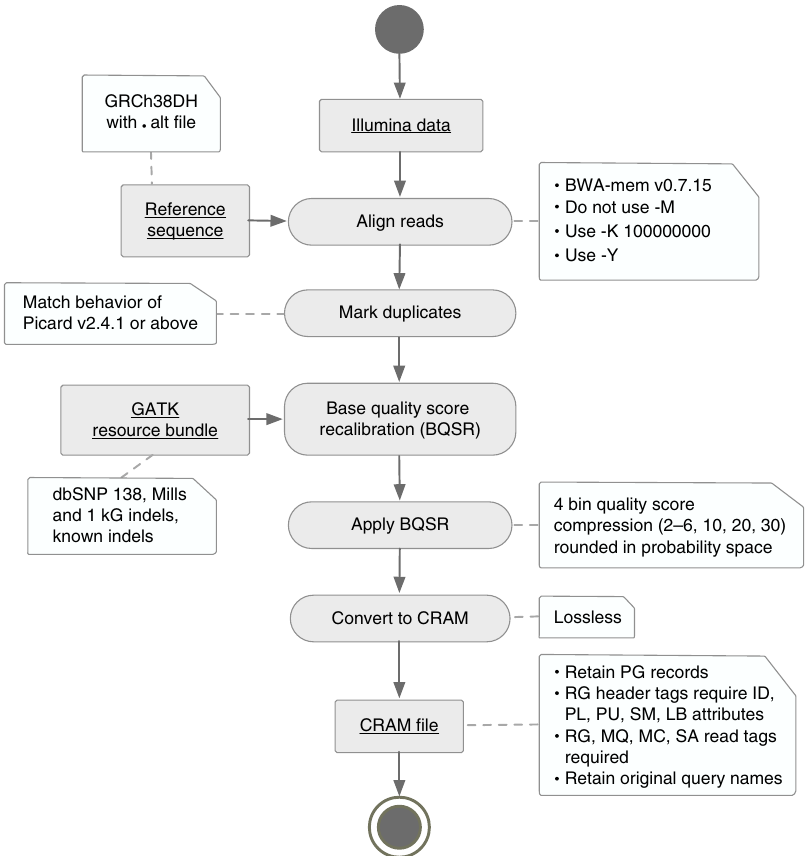
Fig. 1 Highlights of functional equivalence standard. We de fi ned a series of required and allowed processing steps that provide fl exibility in pipeline implementation while keeping variation between pipelines at a minimum. Reads must be aligned to a speci fi c reference genome using a minimum version of the BWA-MEM aligner. Algorithms for marking duplicates and recalibrating base quality scores are more fl exible and vary somewhat between centers. Compression of quality scores into four bins saves storage and fi le transfer costs, while maintaining acceptable accuracy and